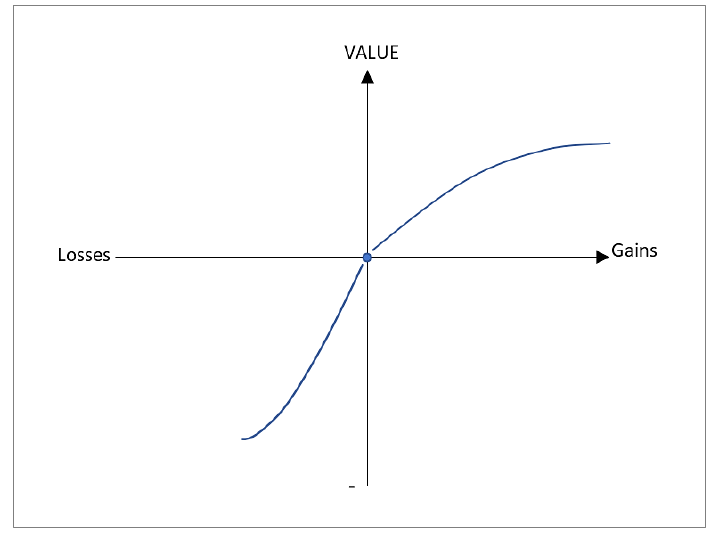
Figure 7. Graph illustrating singularity point of discontinuity in PT